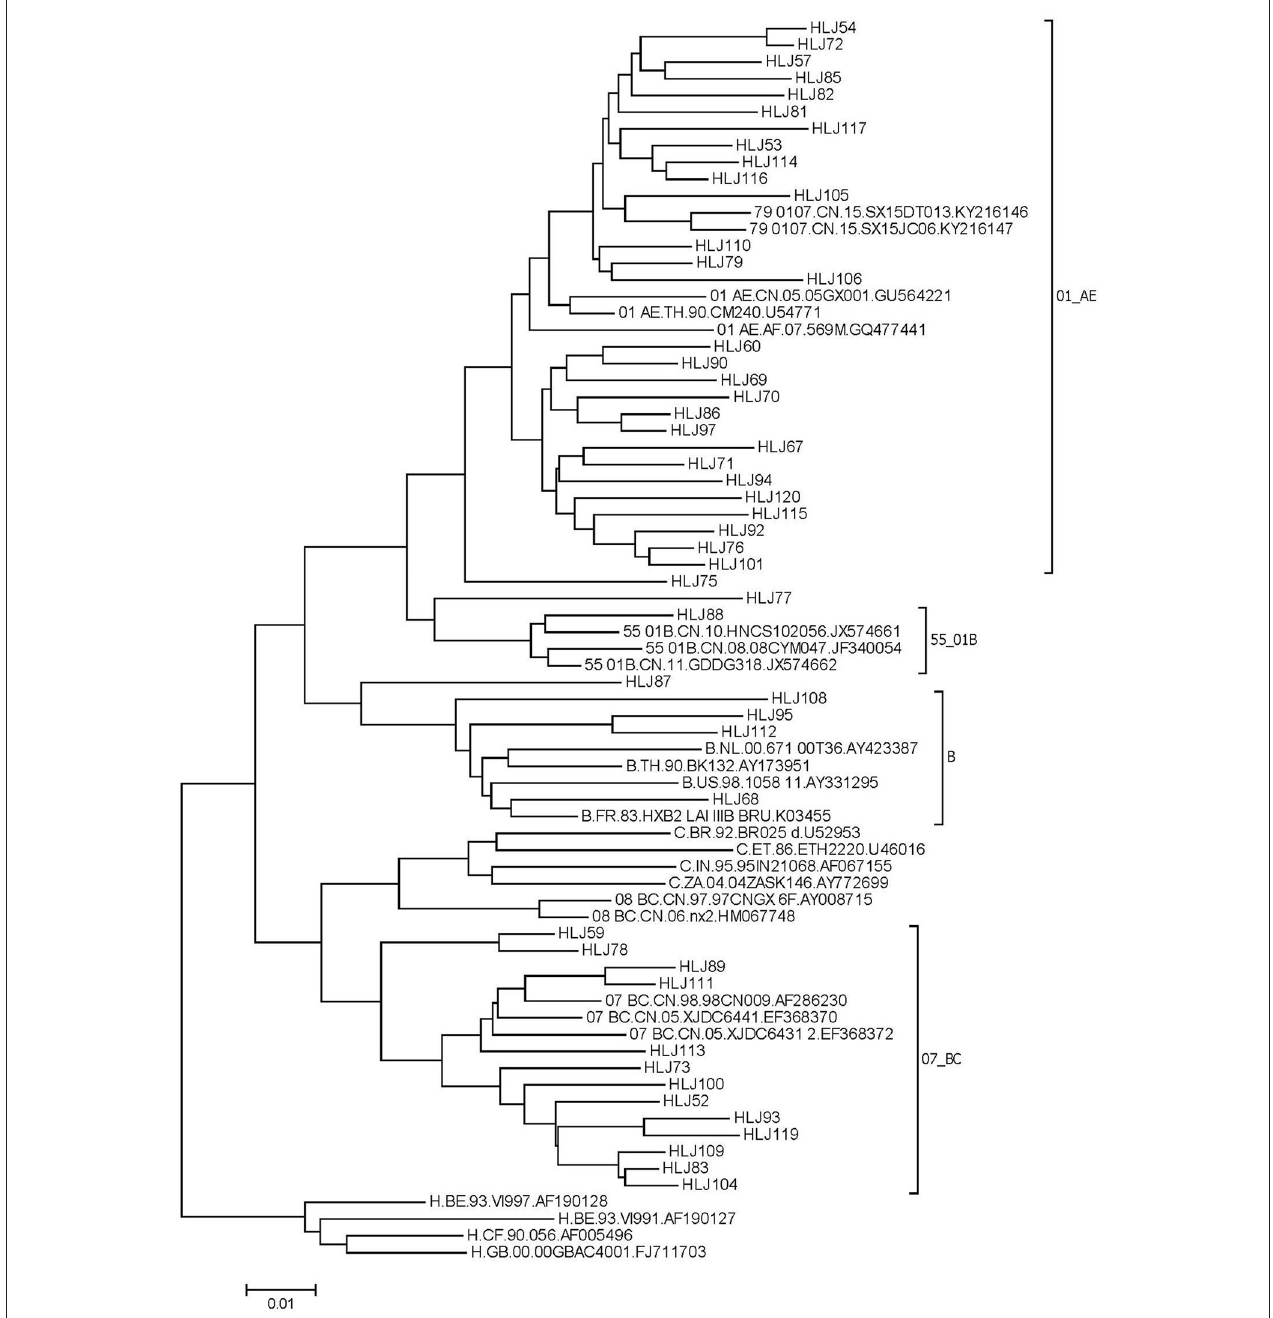
FIGURE 2 | Phylogenetic tree of HIV pol gene in MSM in